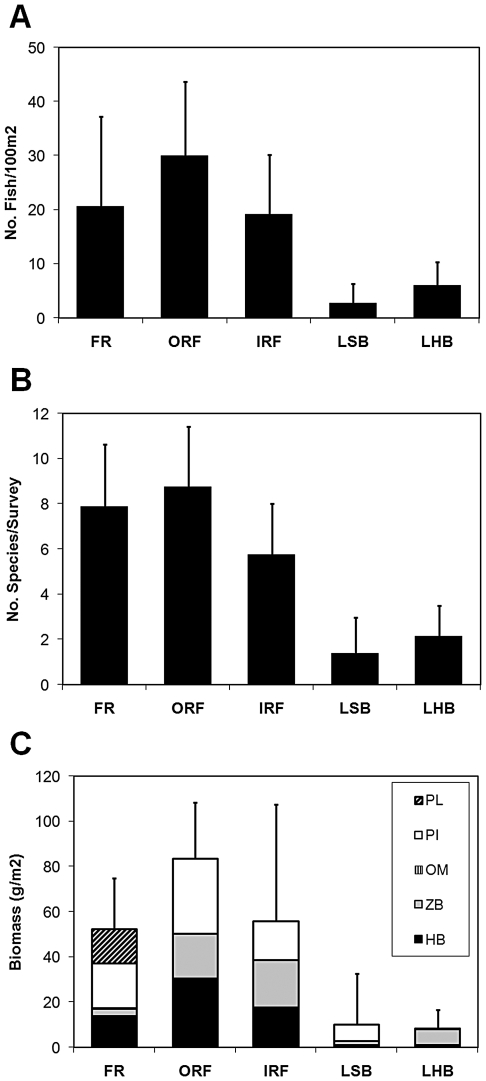
Fish assemblage structure across Saba Bank habitat types.Results of belt transect visual surveys are shown for each of the five different habitat types for: A) fish density; B) fish species richness; and C) estimates of biomass. The average values are presented for each habitat type (eight surveys per habitat). Error bars show standard deviation. Habitat types are abbreviated as in Figure 3. Trophic guilds are: planktivore (PL); piscivore (PI); omnivore (OM); zoobenthivore (ZB); herbivore (HB).